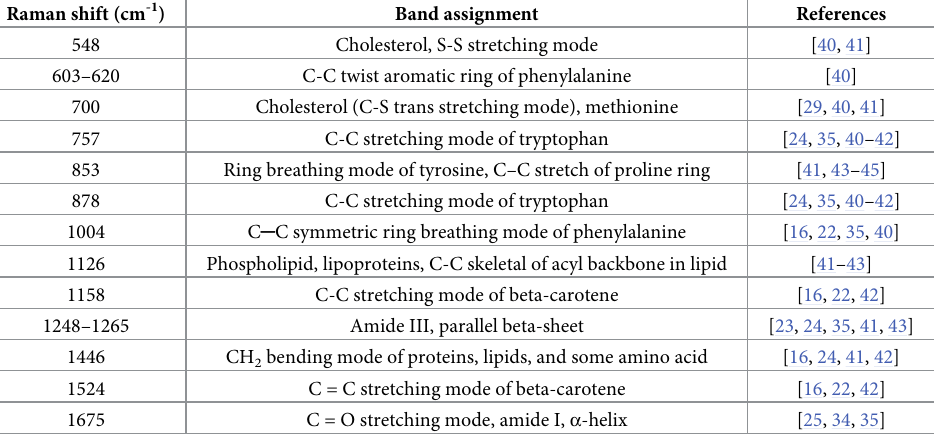
Table 1. Peak positions and assignments of major Raman spectral peaks observed in serum of cholangiocarci- noma patients. Raman shift (cm -1